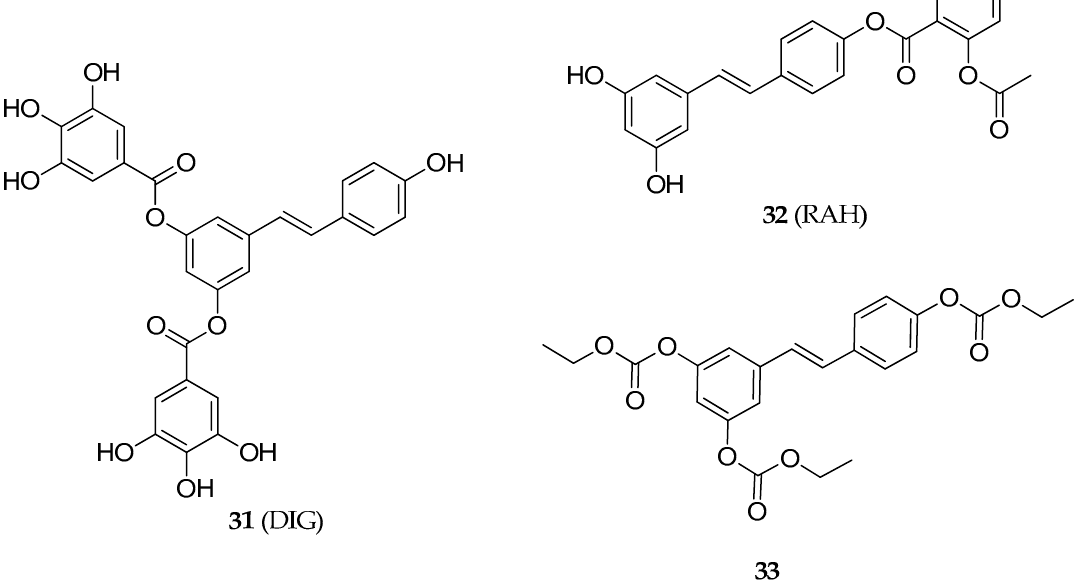
Figure 13. Chemical structures of 3,5- O -digalloylresveratrol (DIG) 31 , RSV-aspirin hybrid (RAH) 32 , and compound 33 .